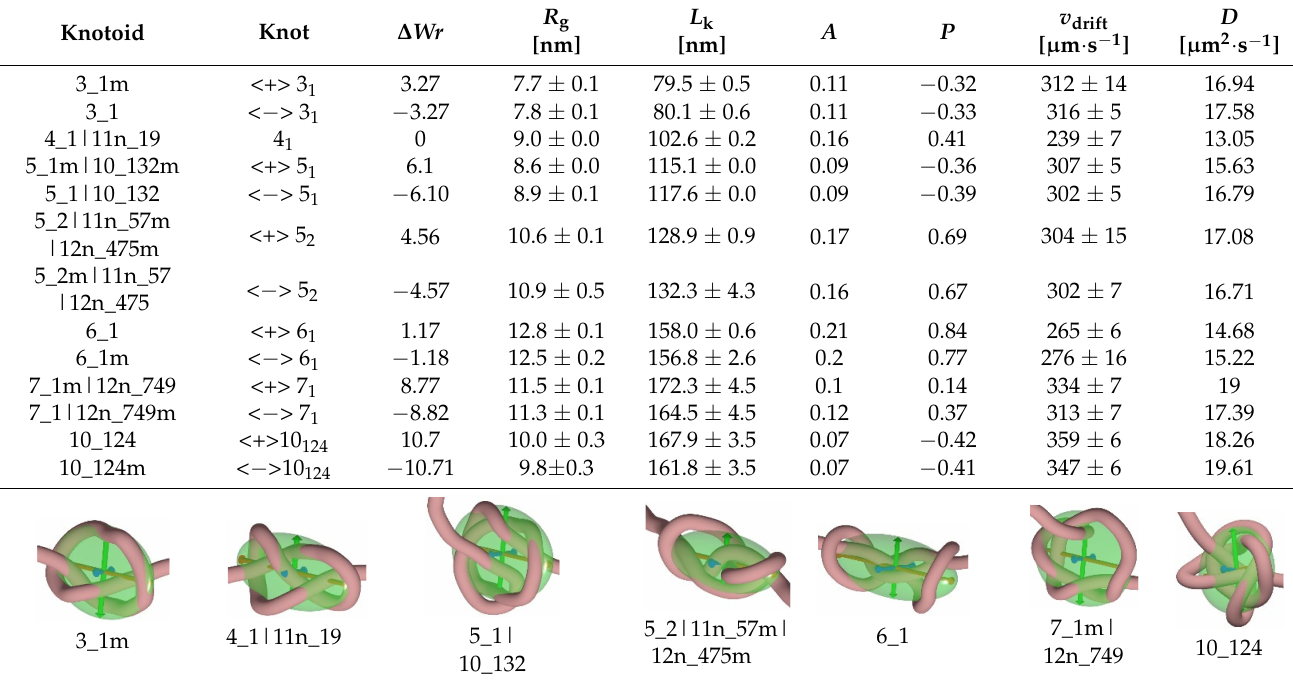
Table 1. Geometrical and dynamic measures of the knotoids. The first column indicates the knotoid name in terms of the convention implemented in the Knoto-ID software [46]. The second column indicates the simplified name of the knot, with the sign corresponding to the sign of writhe; ∆ Wr is the mean value of writhe [100,101]; R g is gyration radius; L k is the contour length of the knot; A is the asphericity; P is the prolateness [99]; v drift and D are dynamic properties, drifting speed and diffusivity. Bottom row also shows representative conformations with their ellipsoids of inertia with the main axes of inertia used for calculating A and P